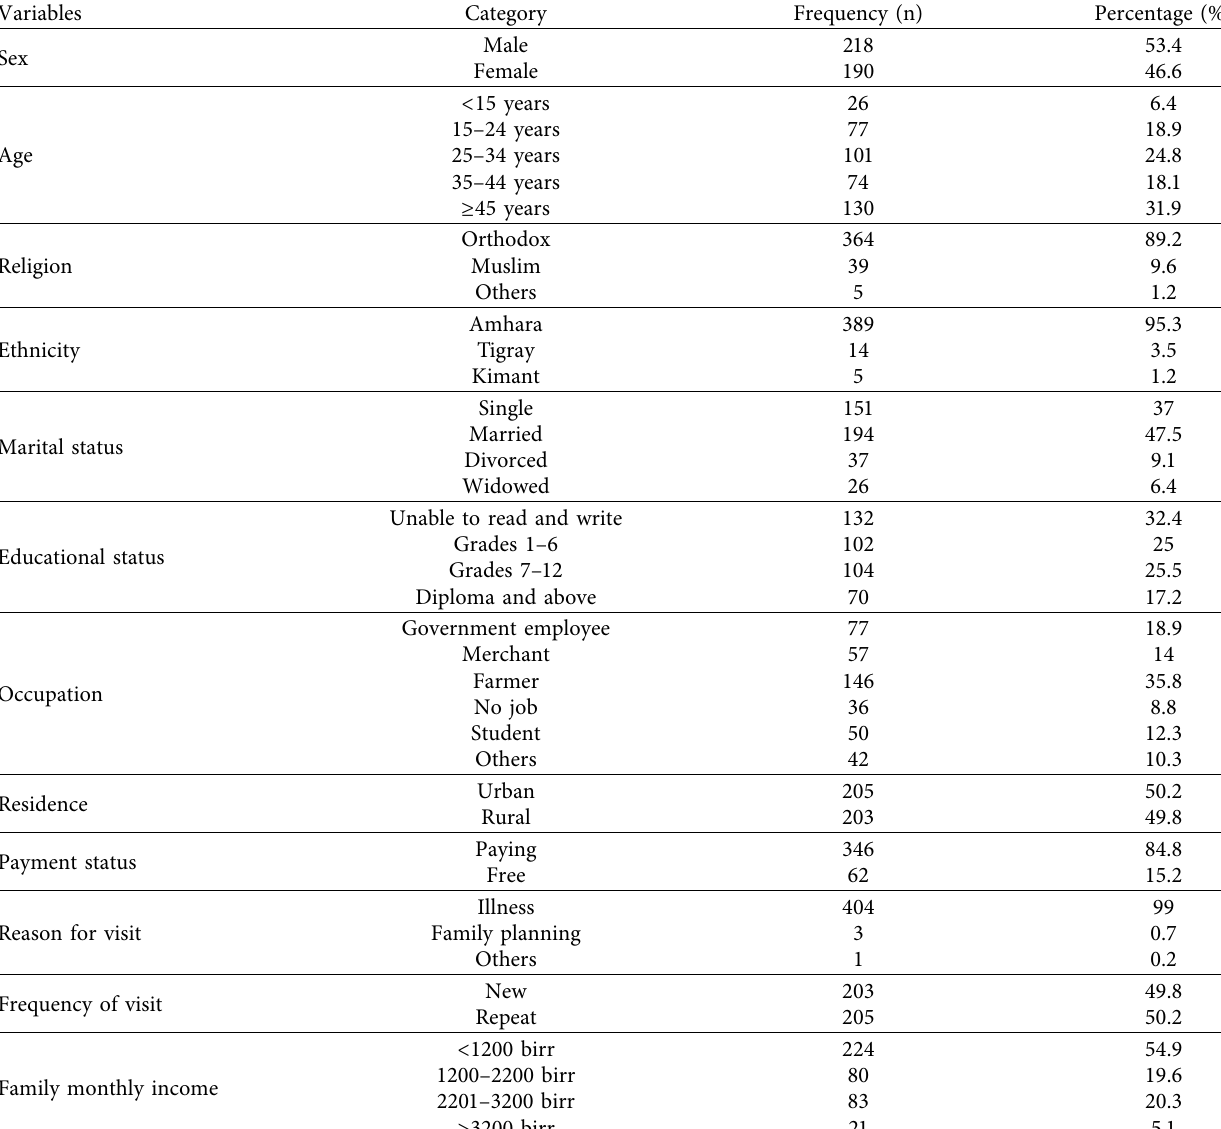
Table 1: Sociodemographic characteristics of the respondents in North Gondar primary hospitals, 2016 ( n � 408).